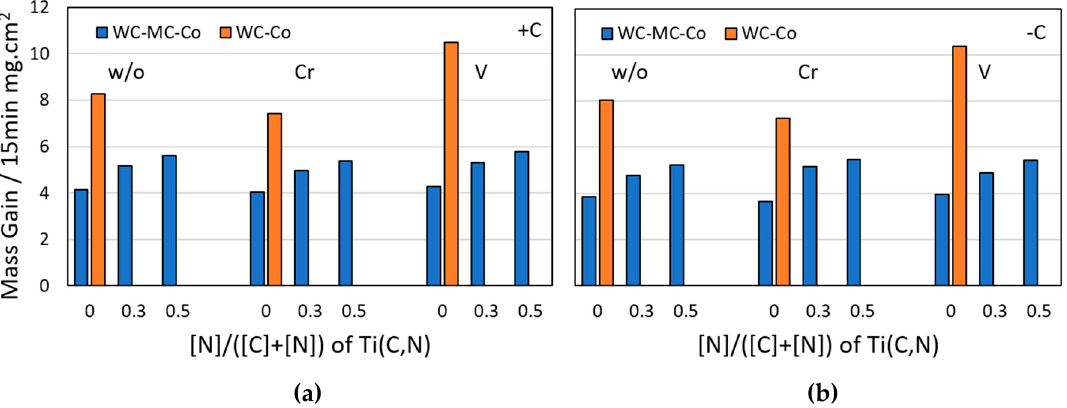
Figure 12. Oxidation behaviour of hardmetals in the air (15 min at 800 °C) as a function of doping and nitrogen content of the added TiC/TiN. ( a ) high-C (Ms ≈ 88%), ( b ) low-C (Ms ≈ 75%) doping.